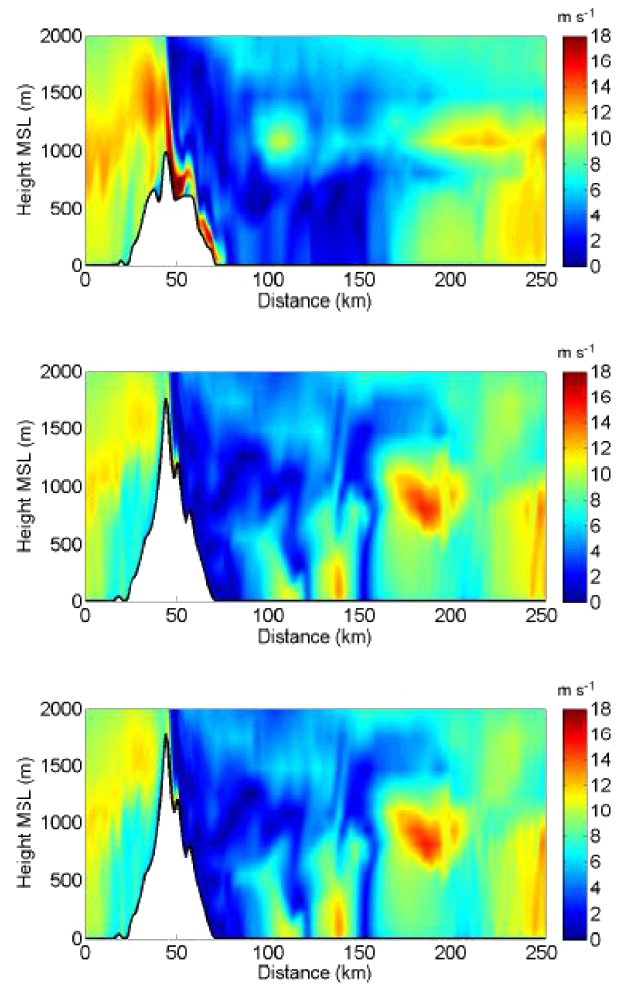
Figure 4. Instantaneous wind speed cross section for the GTOPO30-based (top panel), SRTM30-based (middle panel), and GMTED30-based (bottom panel) simulations at 06:00UTC on 30 April 2007. Cross sections are oriented in the streamwise axis with inflow to the